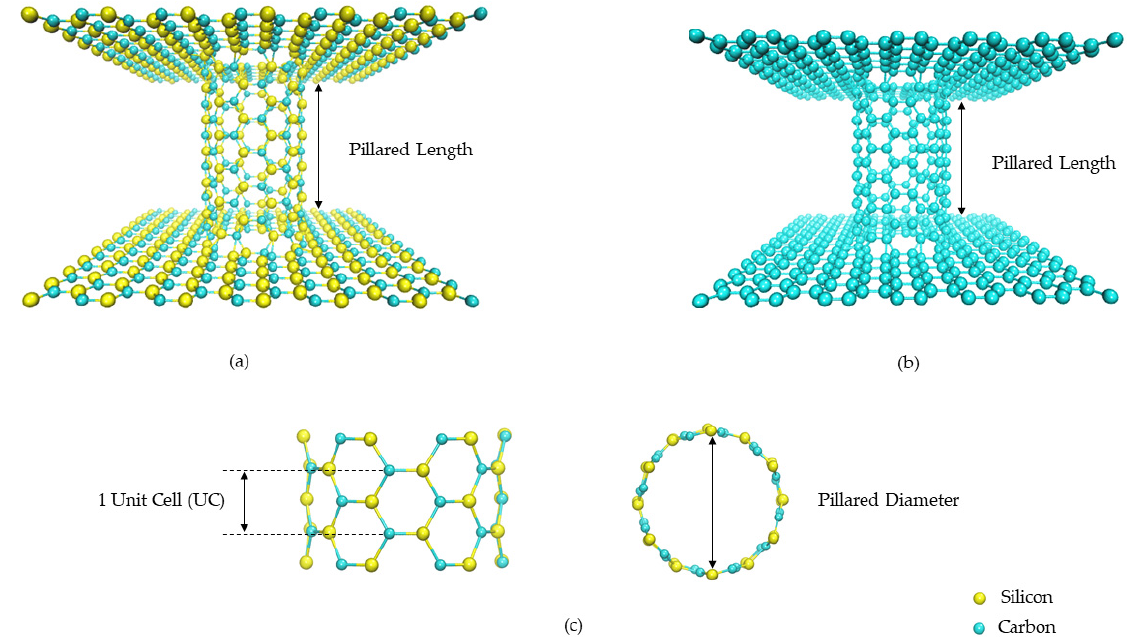
Figure 1. Models of 3D pillared ( a ) SiC and ( b ) C nanostructures. ( c ) Definition of pillar length in one unit cell and pillar diameter.